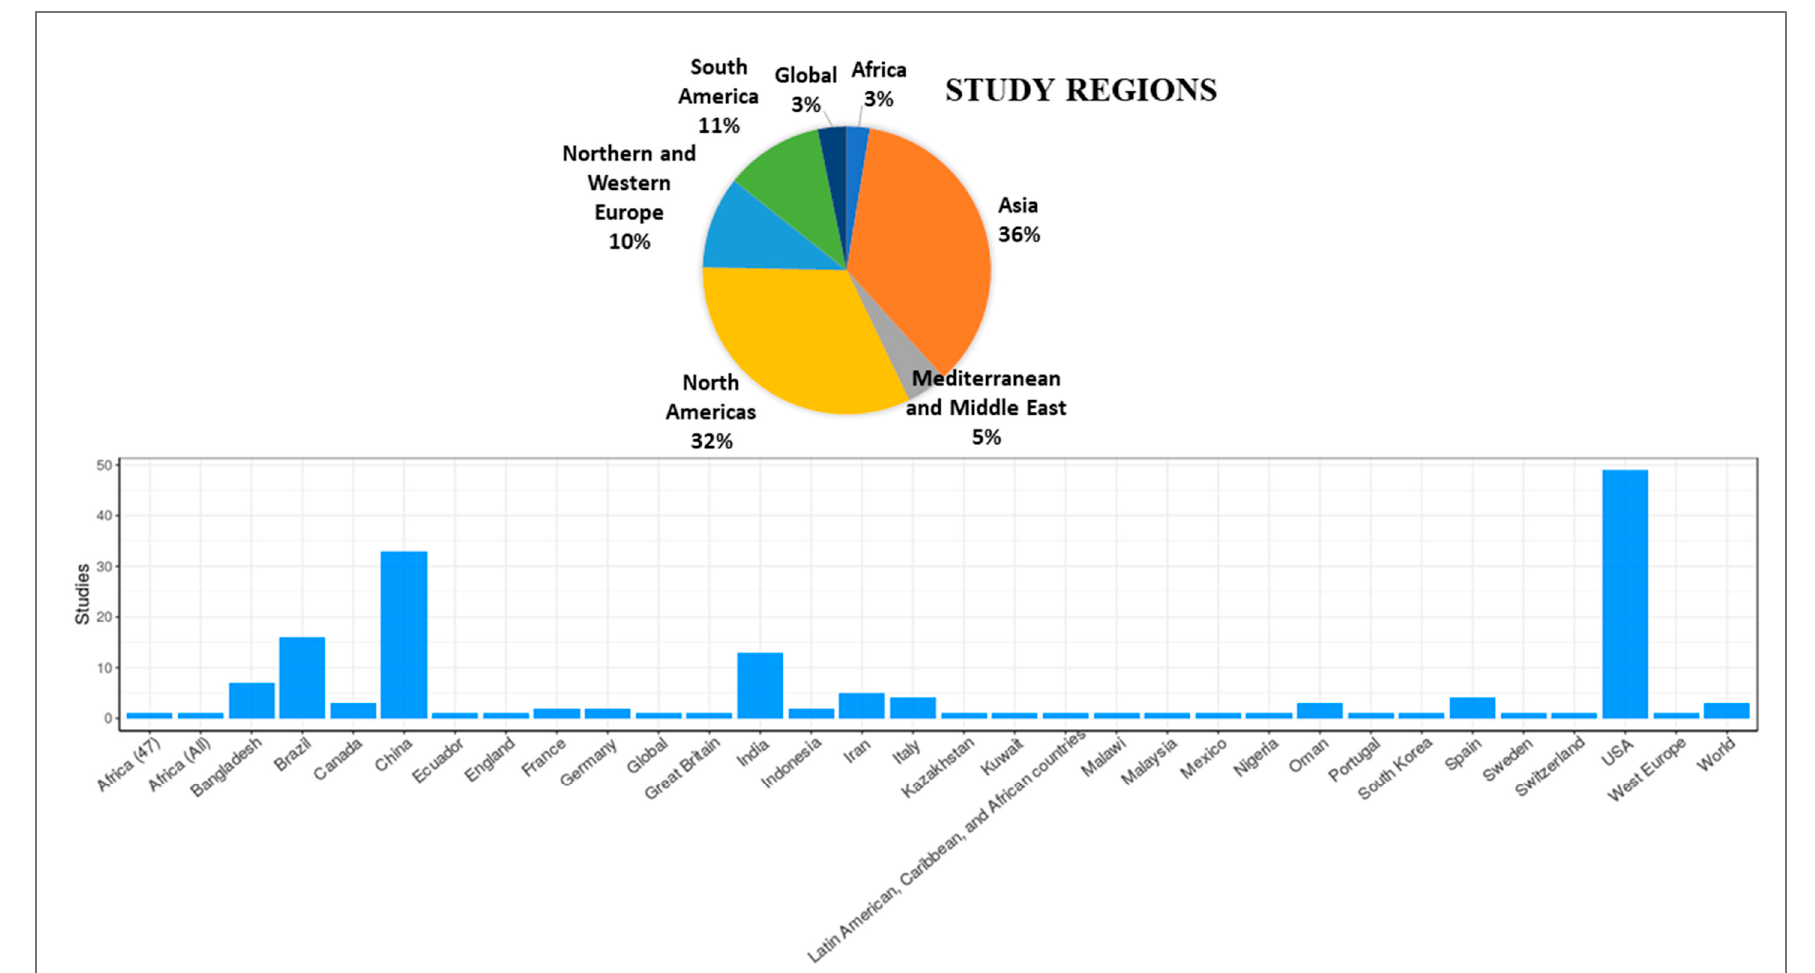
Figure 3. Locations of the study area using spatial methods by region and country ( n = 154).